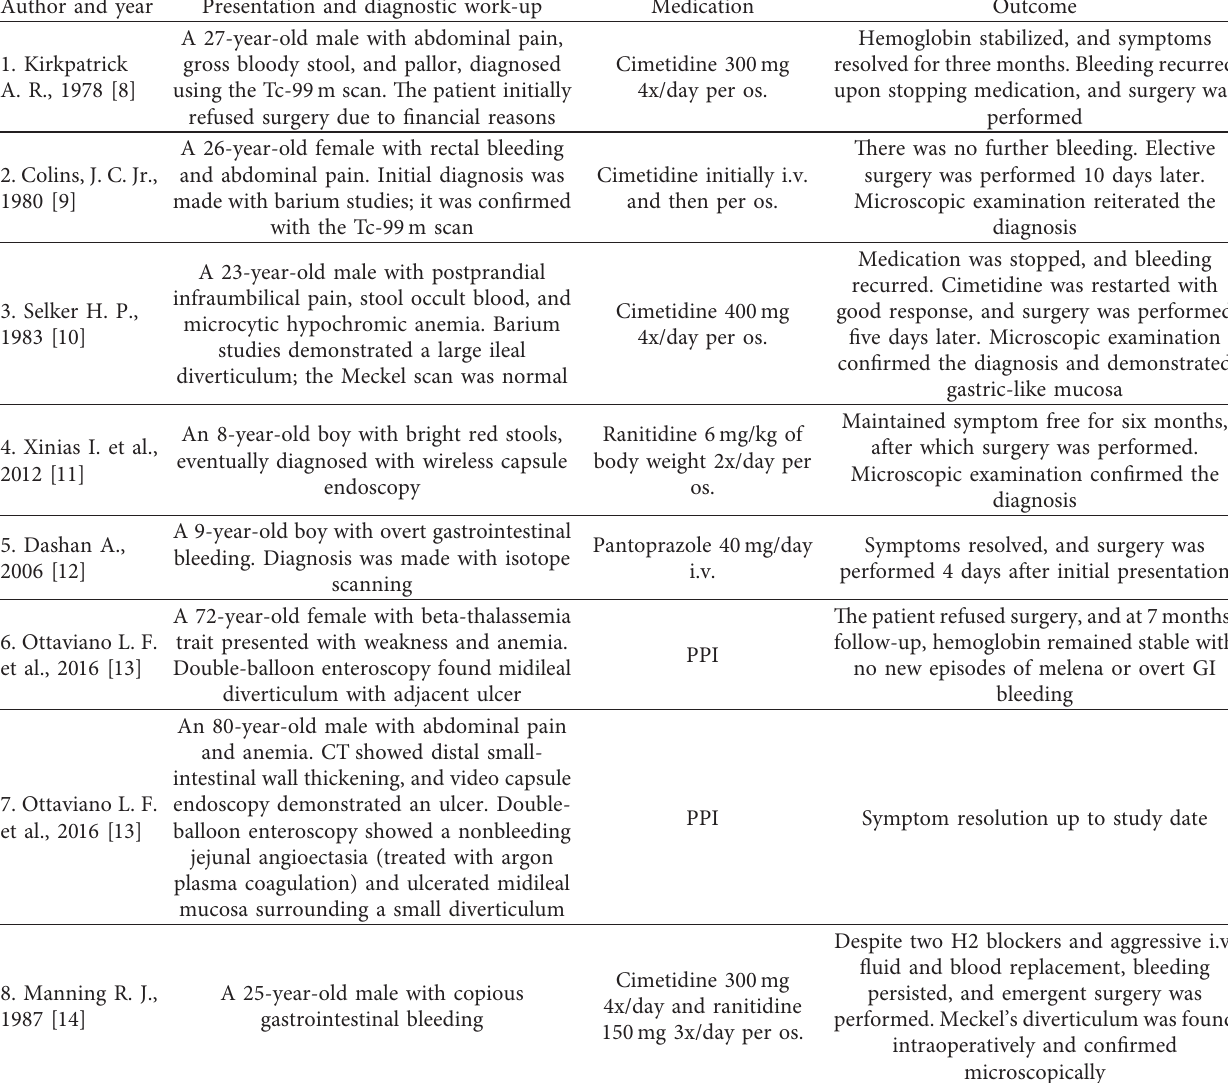
Table 2: Identified cases of Meckel’s diverticulum treated with acid